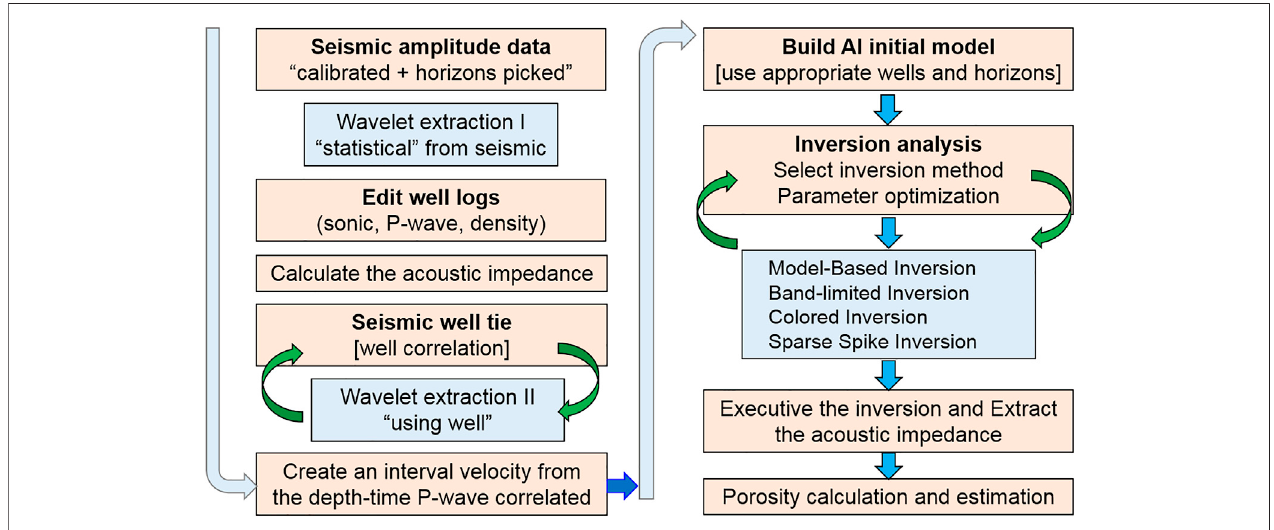
FIGURE 3 | Flowchart outlining the seismic inversion work fl ow to extract the acoustic